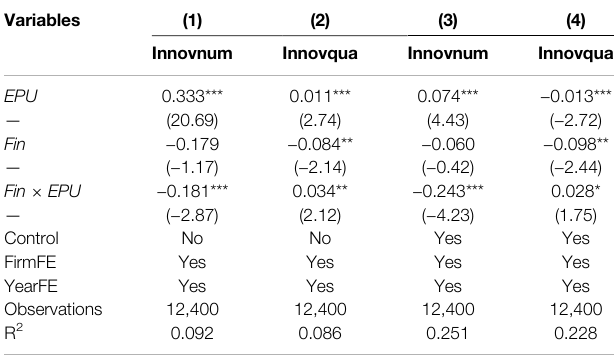
TABLE 10 | Regression results of the moderating effect of fi nancialization.